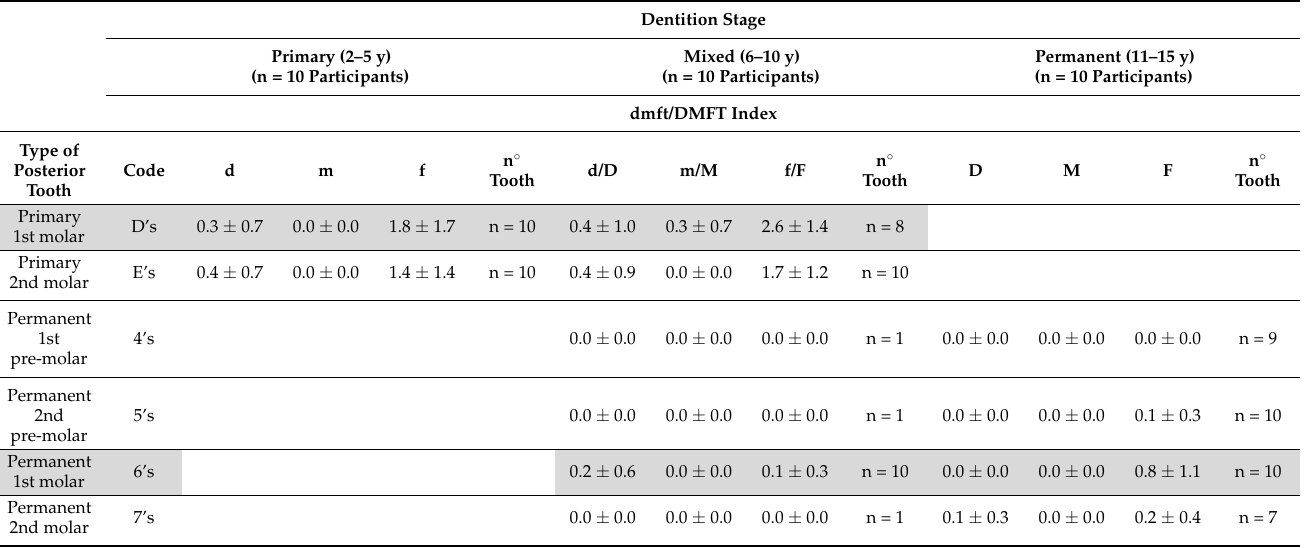
Table A1. Summary of the samples collected in the study. The occlusal plaque of individual posterior teeth (87 samples) was collected from the thirty enrolled participants, and the samples were stratified into three groups according to the dentition stage. The caries experience of each tooth was evaluated using dmft/DMFT index, and detailed caries experience per tooth type are indicated in the table.